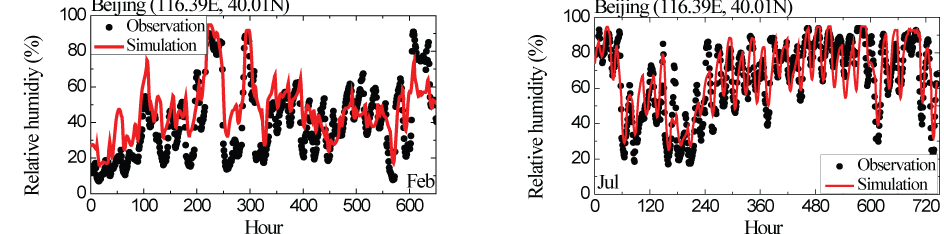
Figure 10. Observed (black circles) and modeled (solid red lines) hourly relative humidity (%) in February and July 2011 in Beijing.